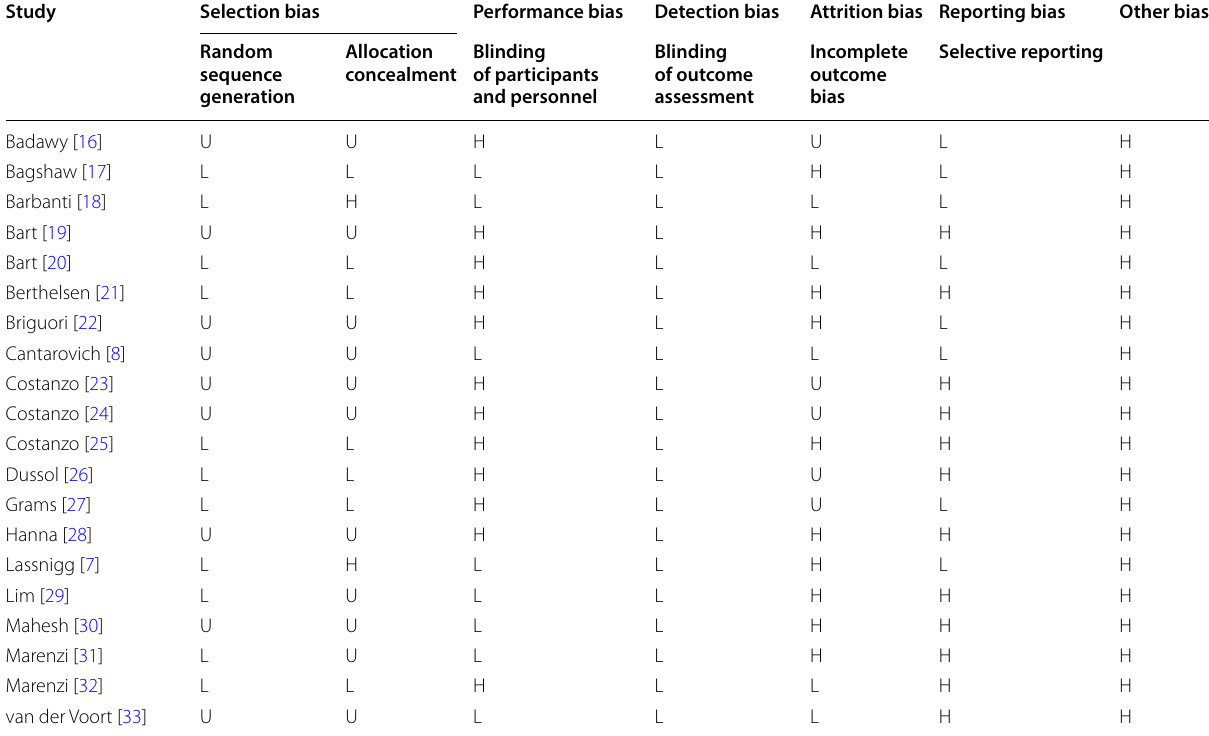
Table 1 Quality assessment of the included studies